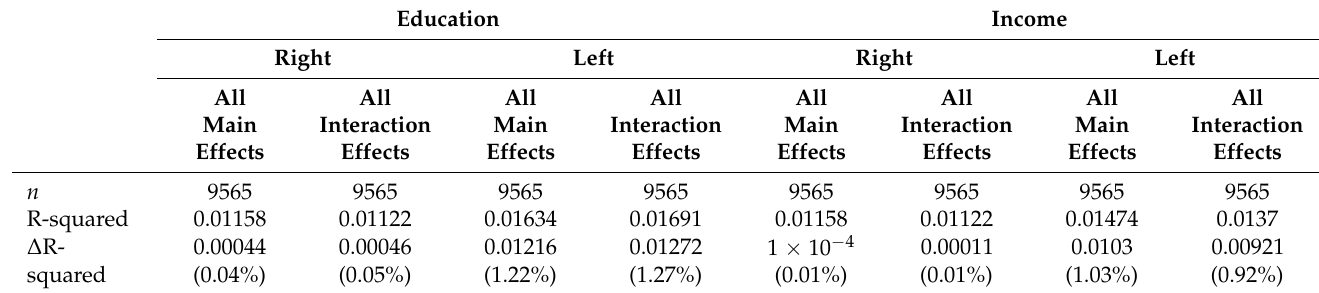
Table 2. Variance explained by our models.